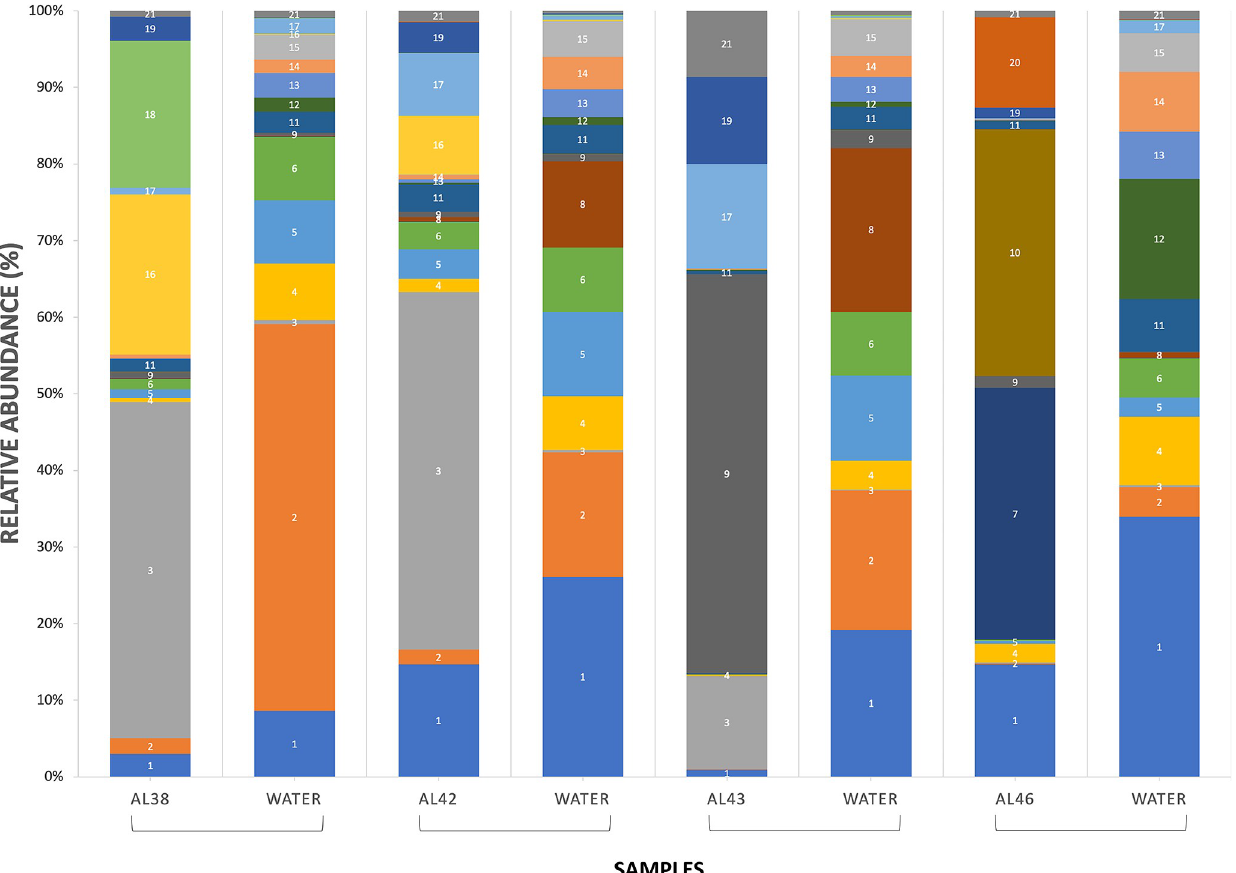
Fig 9. Relative abundances of sequenced Bacteria on polyethylene microplastics (ATR-FTIR confirmed) and paired water samples. Sample number is indicated as AL##. The most abundant OTUs are listed as follows: (1) Bacteria, Proteobacteria, Gammaproteobacteria, Oceanospirillales, Oceanospirillaceae; (2) Bacteria, Proteobacteria, Gammaproteobacteria, Alteromonadales, Alteromonadaceae, Glaciecola; (3) Bacteria, Proteobacteria, Gammaproteobacteria, Pseudomonadales, Pseudomonadaceae, Pseudomonas; (4) Bacteria, Proteobacteria, Gammaproteobacteria, Alteromonadales, Pseudoalteromonadaceae, Pseudoalteromonas; (5) Bacteria, Bacteroidetes, Flavobacteria, Flavobacteriales, Cryomorphaceae, Lishizhenia; (6) Bacteria, Proteobacteria, Gammaproteobacteria, Alteromonadales, Alteromonadaceae, Glaciecola; (7) Bacteria, Proteobacteria, Alphaproteobacteria, Rhodobacterales, Rhodobacteraceae, Pseudoruegeria; (8) Bacteria, Proteobacteria, Gammaproteobacteria, Vibrionales, Vibrionaceae, Vibrio; (9) Bacteria, Bacteroidetes, Flavobacteria, Flavobacteriales, Flavobacteriaceae, Maribacter; (10) Bacteria, Verrucomicrobia, Verrucomicrobiae, Verrucomicrobiales, Rubritaleaceae, Rubritalea; (11) Bacteria, Bacteroidetes, Flavobacteria, Flavobacteriales, Flavobacteriaceae, Flavobacterium; (12) Bacteria, Proteobacteria, Gammaproteobacteria, Pseudomonadales, Pseudomonadaceae, Pseudomonas; (13) Bacteria, Proteobacteria, Betaproteobacteria,